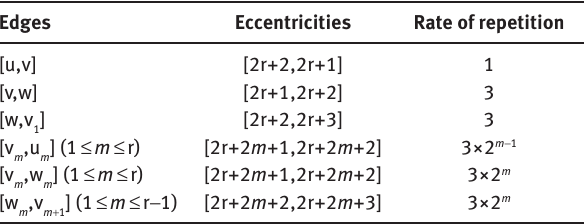
Table 3: The edge distribution of SD [r] with reference to edges and their rate of occurrence. The eccentricities are picked up from Table 1.